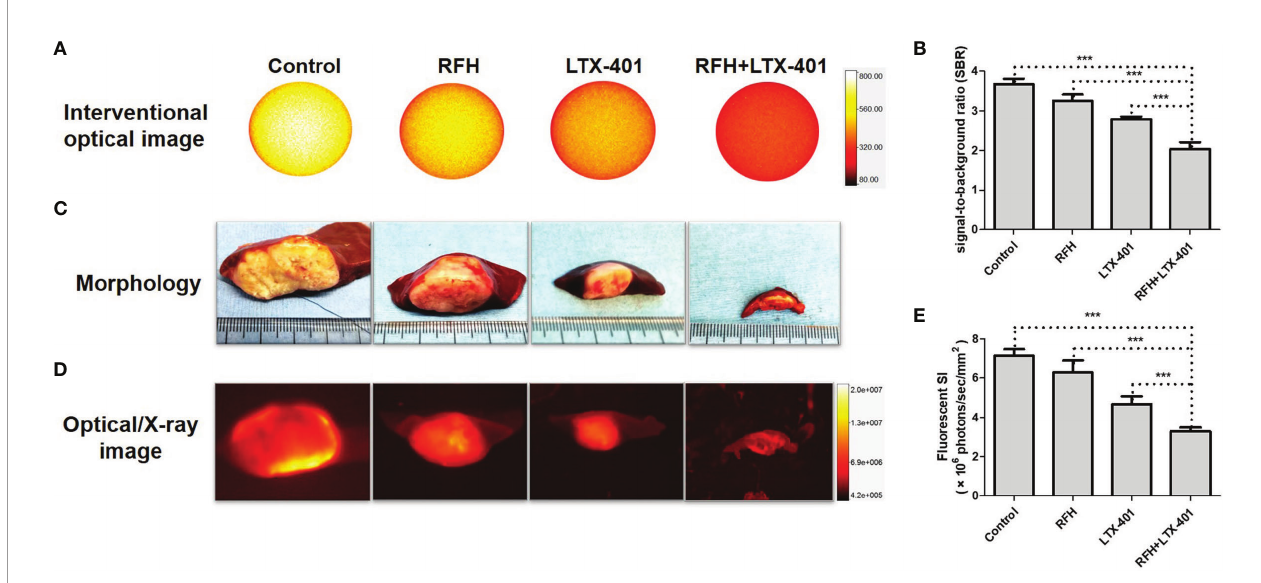
FIGURE 8 | | In-vivo interventional optical imaging, con fi rmed by optical/x-ray imaging. (A, B) Interventional optical images show a signi fi cant decrease of ICG (yellow) signal-to-background ratio (SBR) with the combination therapy of RFH + LTX-401 (***= P <0.005). (C) Morphology demonstrates the smallest tumor size, and (D, E) Optical/X-ray images further con fi rm that combination therapies of oncolytic LTX-401 with RFH results in signi fi cant decrease of the average fl uorescent SI of tumors in the combination therapy group, compared to the other three groups (***= P <0.005).